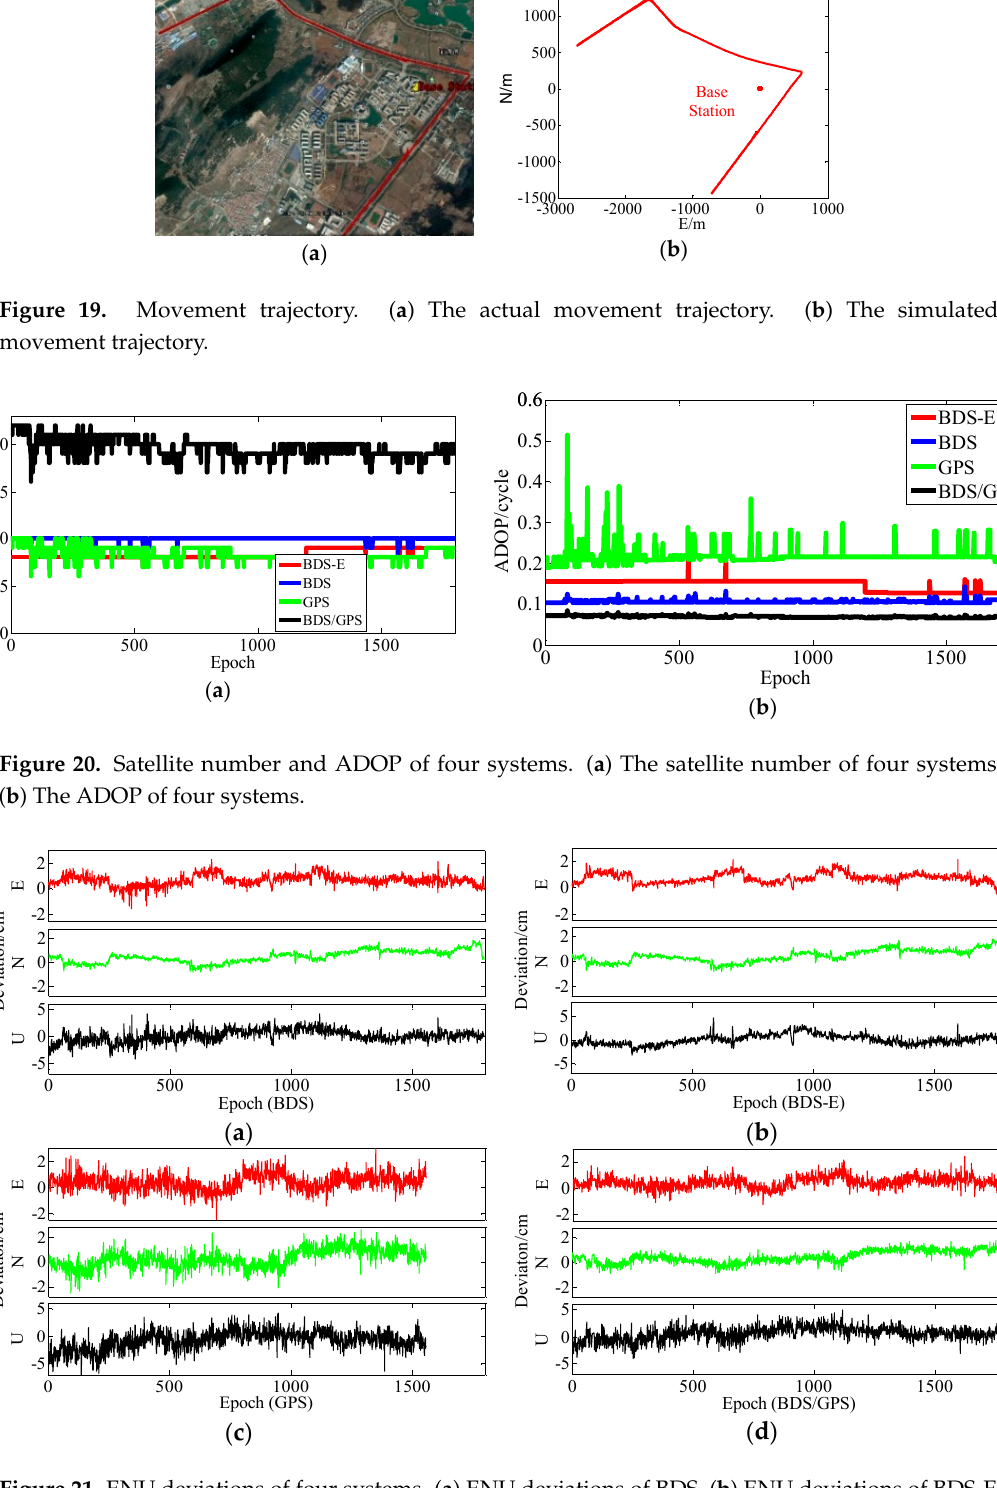
Figure 21. ENU deviations of four systems. ( a ) ENU deviations of BDS. ( b ) ENU deviations of BDS-E. ( c ) ENU deviations of GPS. ( d ) ENU deviations of BDS/GPS.